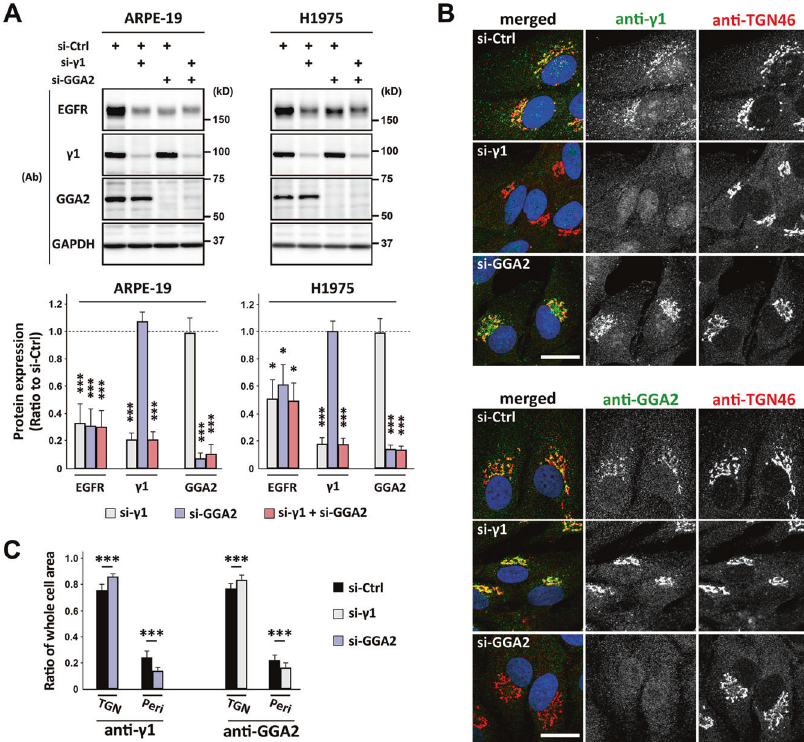
to si-Ctrl is plotted as the mean ± SD (of six and three experiments for ARPE-19 and H1975, respectively). Statistical differences between each siRNA and si-Ctrl were analyzed using Student ’ s t -test (* P < 0.05 and *** P < 0.001). B ARPE-19 cells transfected with si-Ctrl, si- γ 1, or si-GGA2 were fi xed for double immuno fl uorescence microscopy using antibodies against TGN-46 (red) and γ 1-adaptin (green) or GGA2 (green), as indicated. Nuclei were stained with Hoechst 33342 (blue). Bars, 20 μ m. C Fluorescence intensities for γ 1-adaptin (anti- γ 1) or GGA2 (anti-GGA2) in both TGN and peripheral (Peri.) regions were quanti fi ed in 40 cells for each siRNA experiment. Statistical differences between each siRNA and si-Ctrl were analyzed using Student ’ s t -test (*** P <